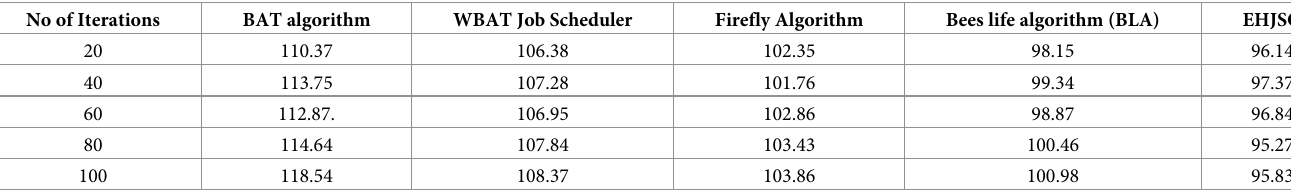
Table 2. Makespan analysis for EHJSO method with existing